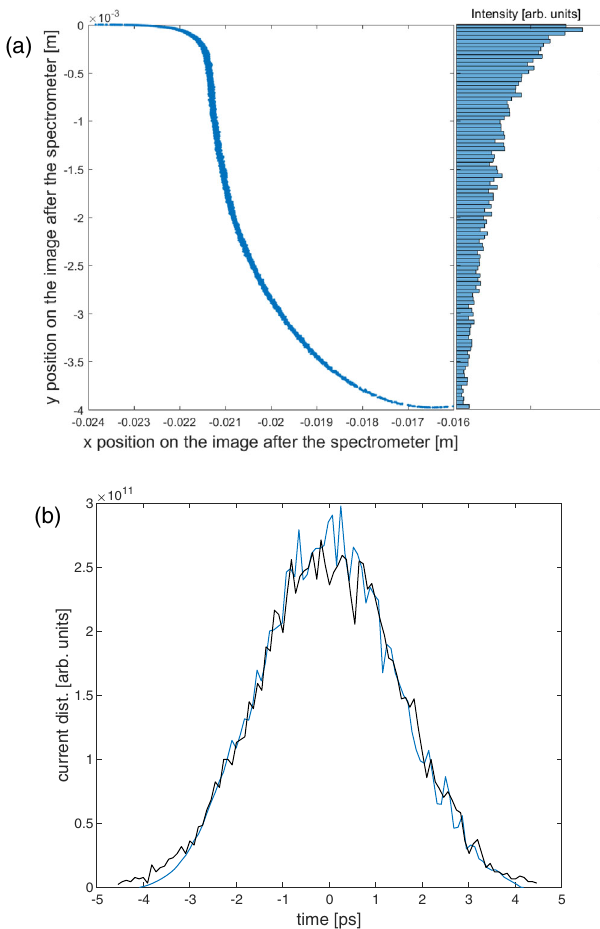
FIG. 4. (a) Simulation results of the two-dimensional particle distribution and intensity distribution f ð y Þ of the pencil beam on screen-6, and (b) corresponding current distributions. The blue line in (b) represents the input current distribution at the dechirper and the black line the reconstructed current